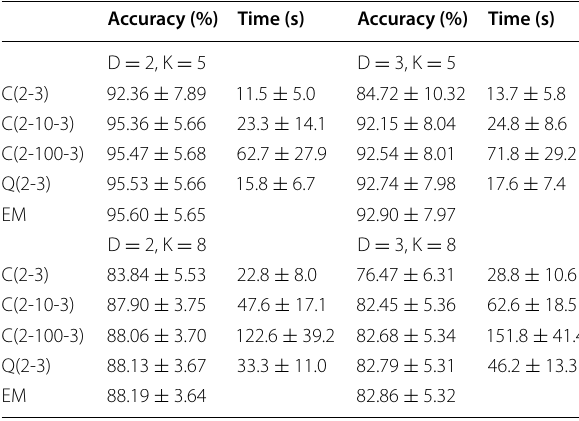
Table 2 The average accuracy of and time needed by EM algorithm, Q and C neural networks with different numbers of neurons in 2D and 3D spaces with K = 5 and 8 Gaussian clusters. The notation ( · ) stands for the architecture of a neural network as described in Eq. 15